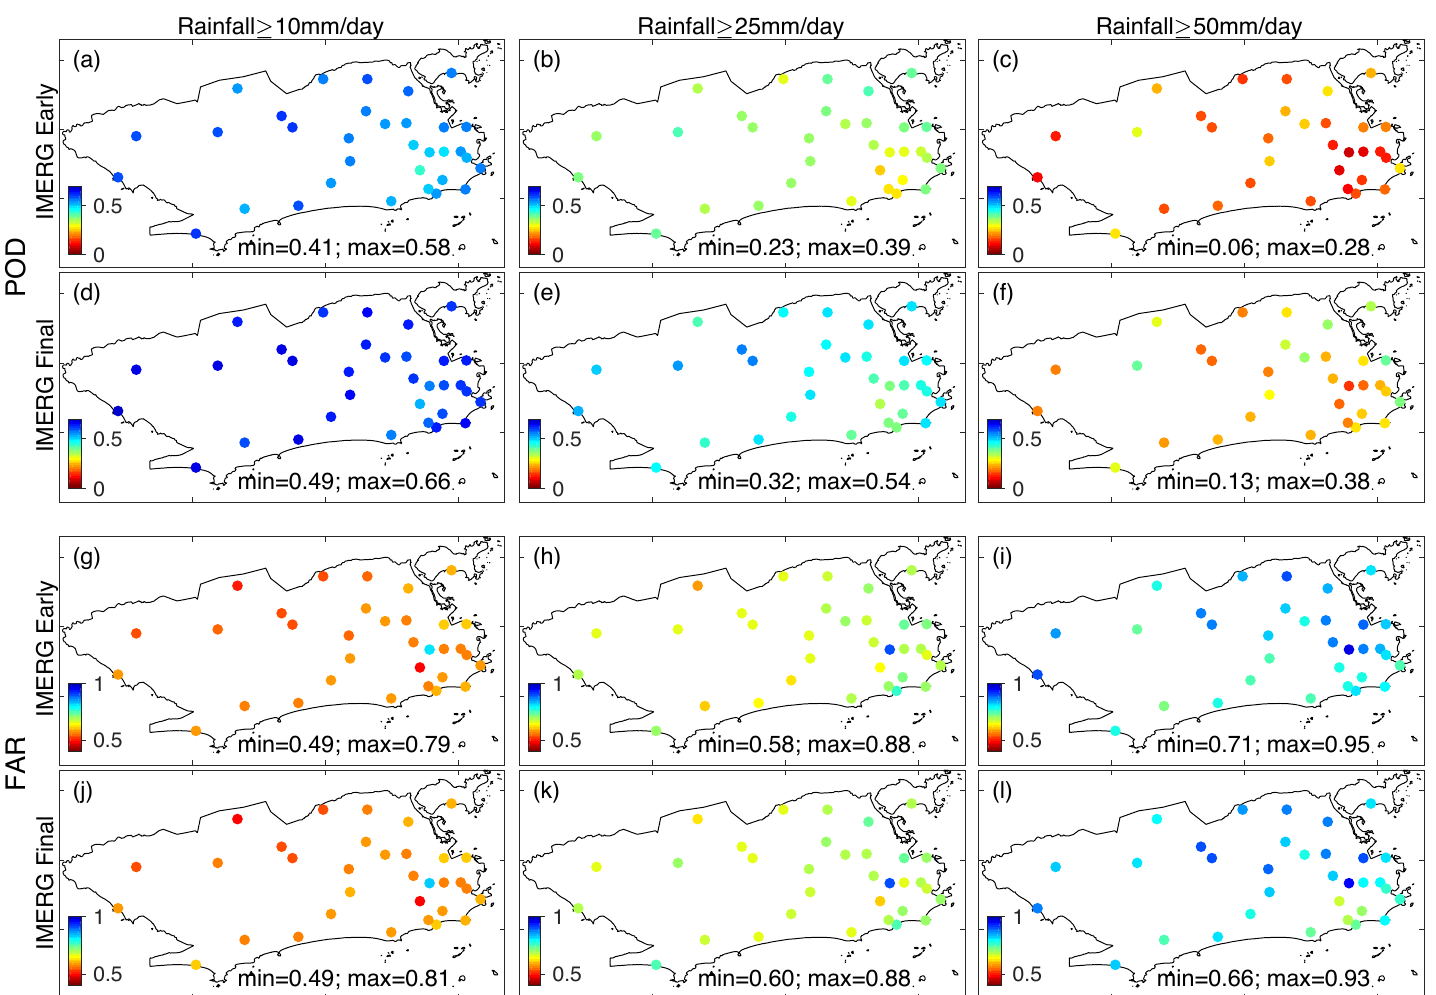
Figure 3. Probability of detection (POD) and false alarm rate (FAR) maps at three rainfall thresholds ( ≥ 10 mm / day, ≥ 25 mm / day and ≥ 50 mm / day) for IMERG